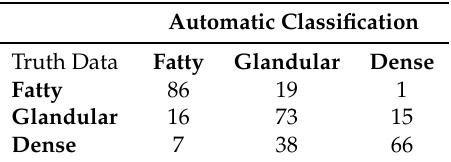
Table 2. Confusion matrix for automatic tissue classification using Local Binary Pattern (LBP) descriptor for ROI size 256 ×